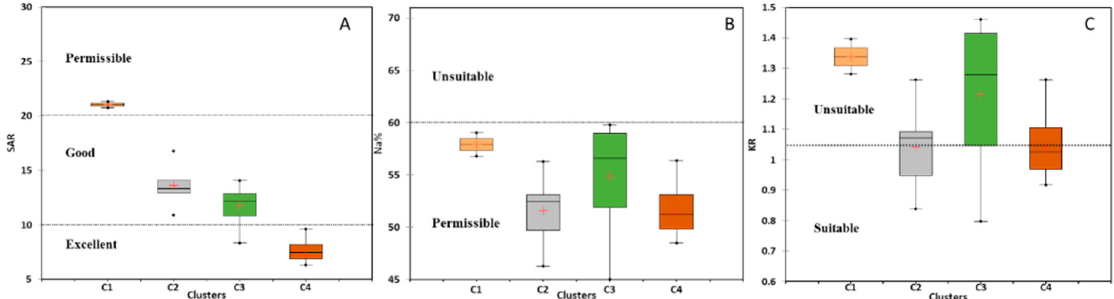
Figure 8. Variations in the sodium irrigation hazards of tested GW for all clusters (C1, C2, C3, and C4) (+ represent the median values). ( A ) SAR, ( B ) Na%, and ( C ) KR.